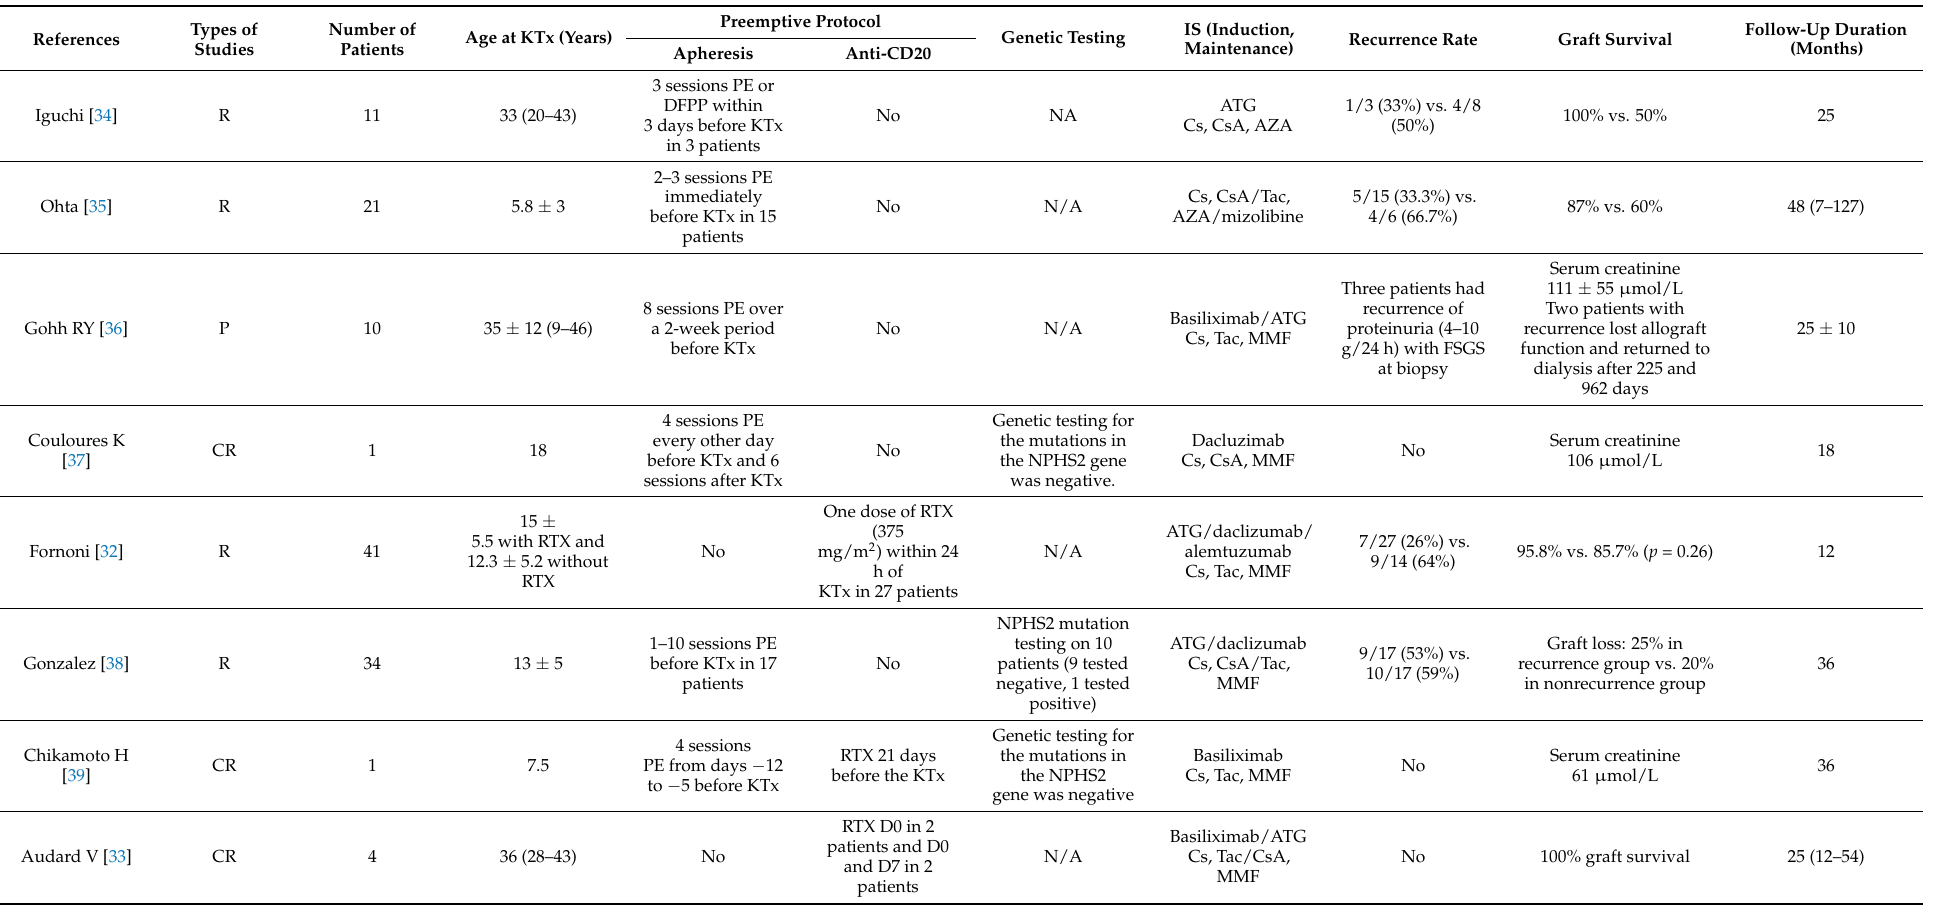
Table 3. Studies evaluating apheresis and anti-CD20 in prevention of FSGS